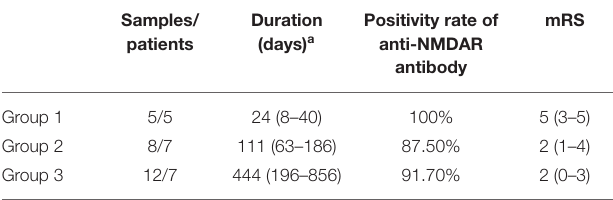
TABLE 3 | Basic data of patients with anti-N-methyl-D-aspartate receptor (NMDAR) encephalitis at different stages of the disease. Samples/ patients